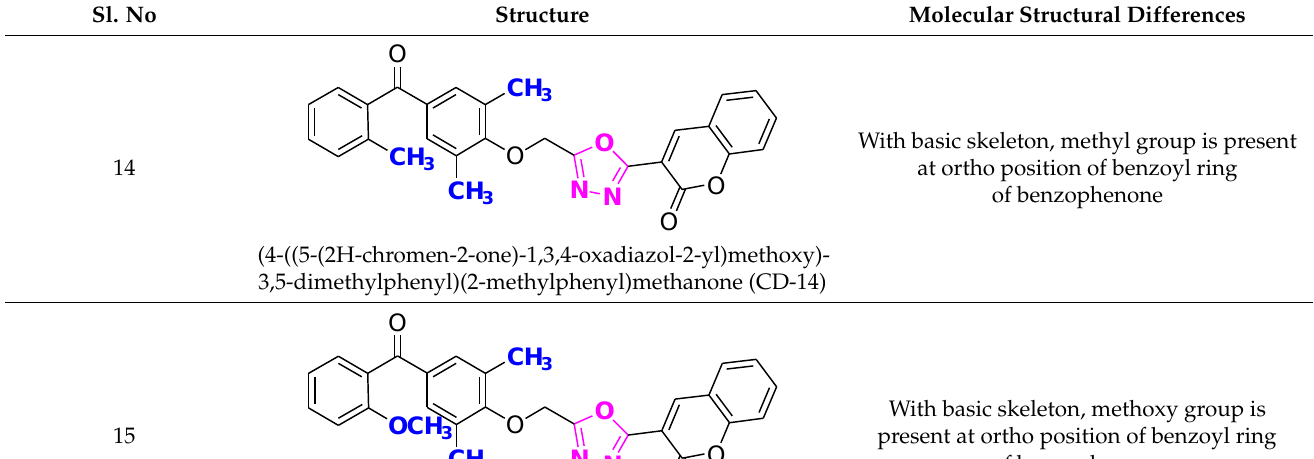
(4-((5-(2H-chromen-2-one)-1,3,4-oxadiazol-2-yl)methoxy)- 3,5-dimethylphenyl)(2-methylphenyl)methanone (CD-14)